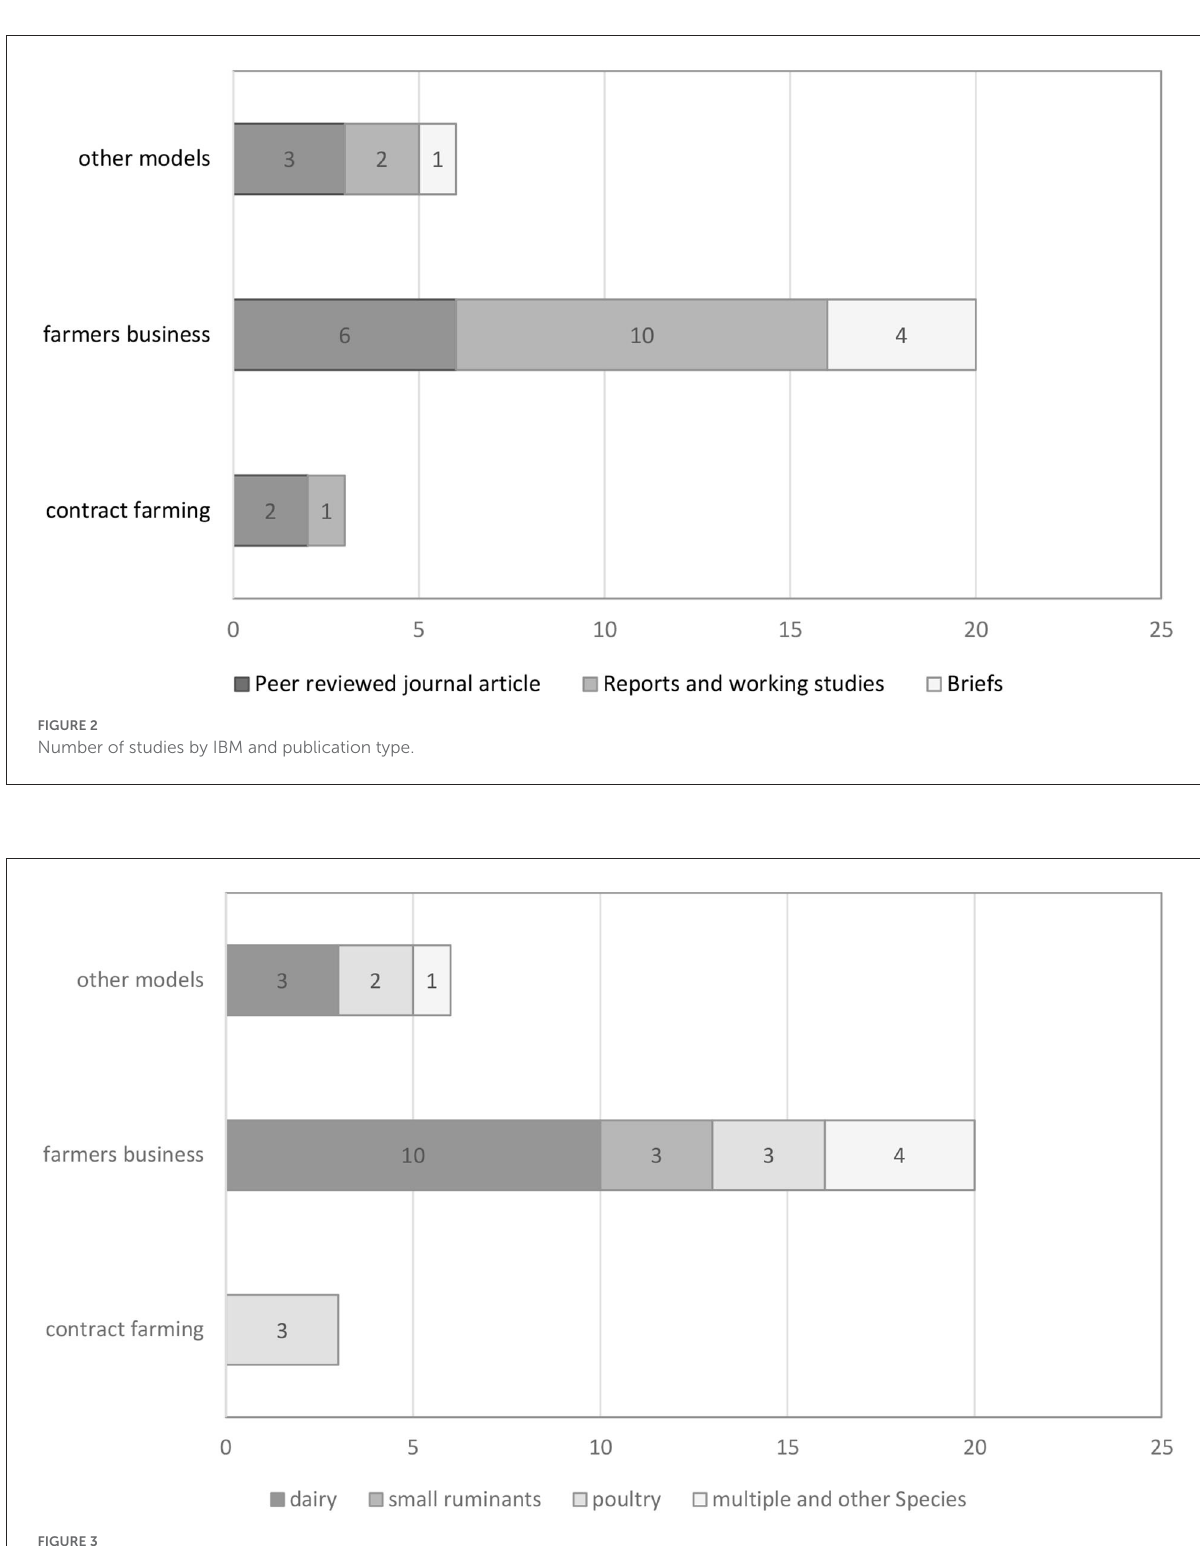
FIGURE3 Number of studies by IBM and livestock